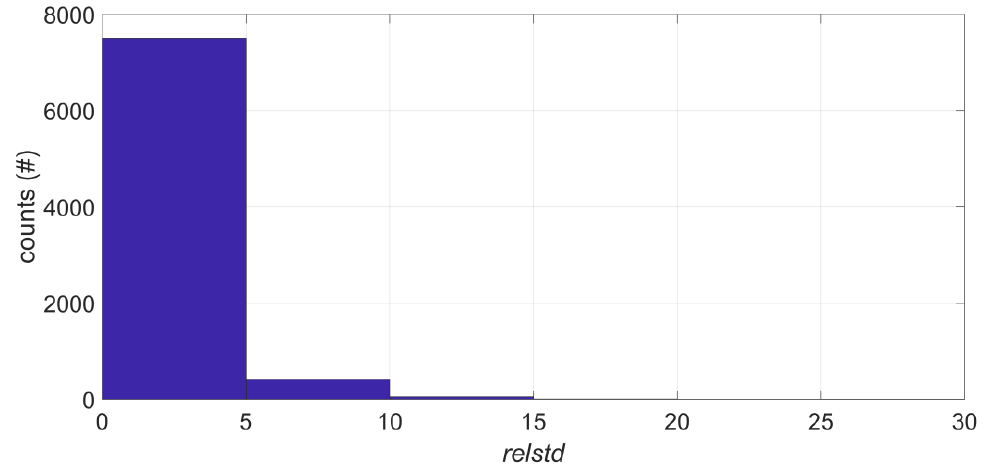
Figure 16. The distribution of the relstd values obtained for September 2020.